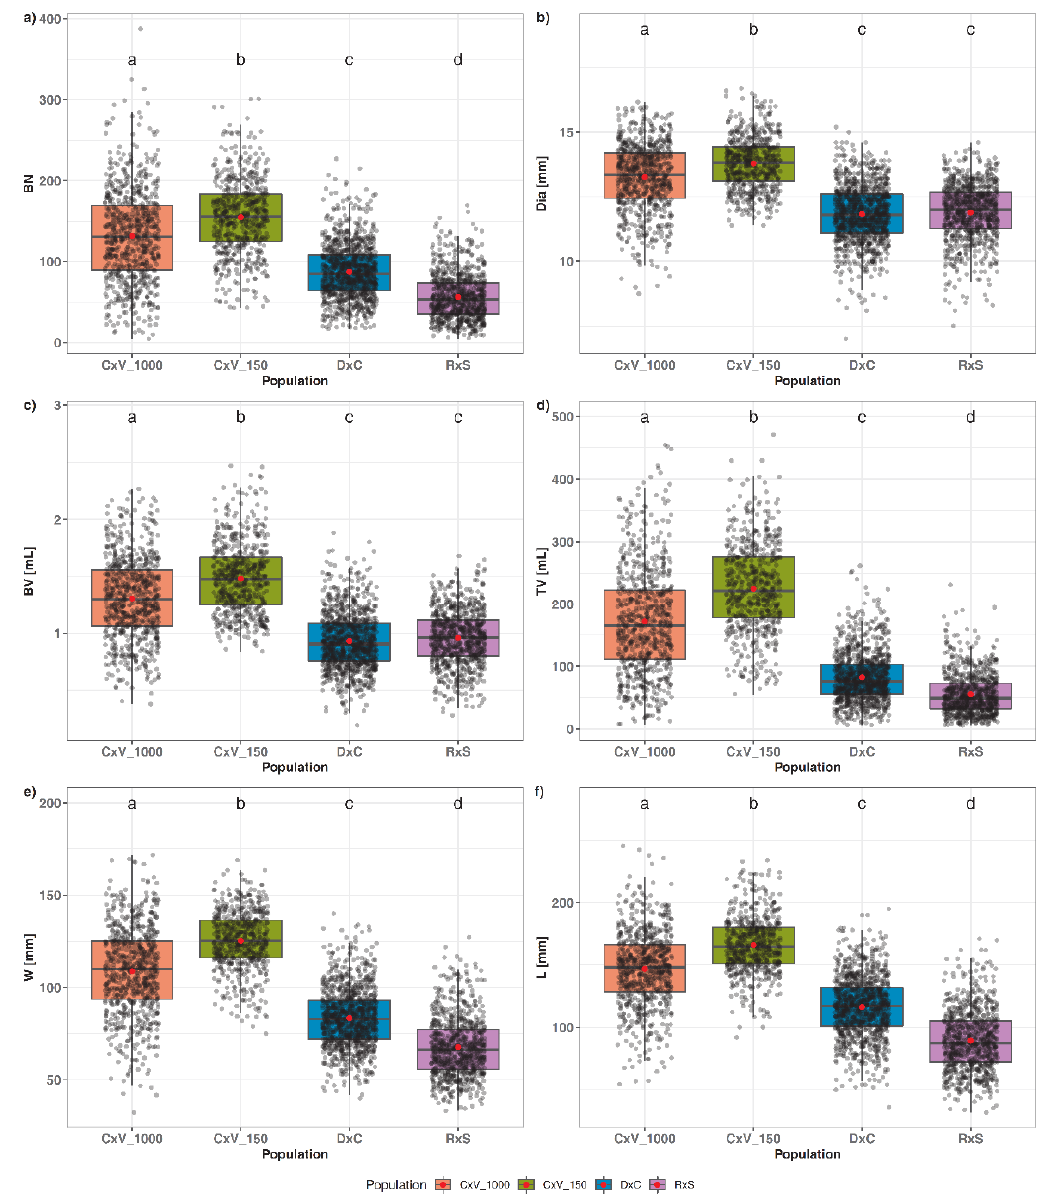
Figure 3. ANOVA results for the phenotypic values of the investigated populations. Distribution of the phenotypic values for C × V_1000 (red, n = 722), C × V_150 (green, n = 150), D × C (cyan, n = 347), and R × S (purple, n = 295). Berry number = BN ( a ), berry diameter = Dia, ( b ) berry volume = BV ( c ), total volume = TV ( d ), bunch width = W ( e ), and bunch length = L ( f ). Groups that are indicated by the same letter do not differ at an alpha of 0.05 (Tukey’s test). Note that phenotypic data of the C × V_1000 population were one-year data from 2018. Datapoints from further populations are mean values from the respective three consecutive seasons.